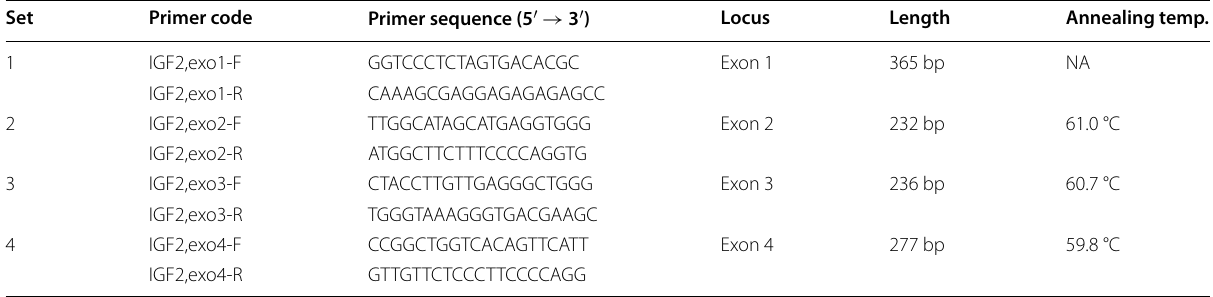
Table 1 The oligonucleotide primer sets designed for the amplification of the IGF2 in three populations of Japanese quails. The present annotations of this study variants were based on GenBank accession number NC_029520.1 Set